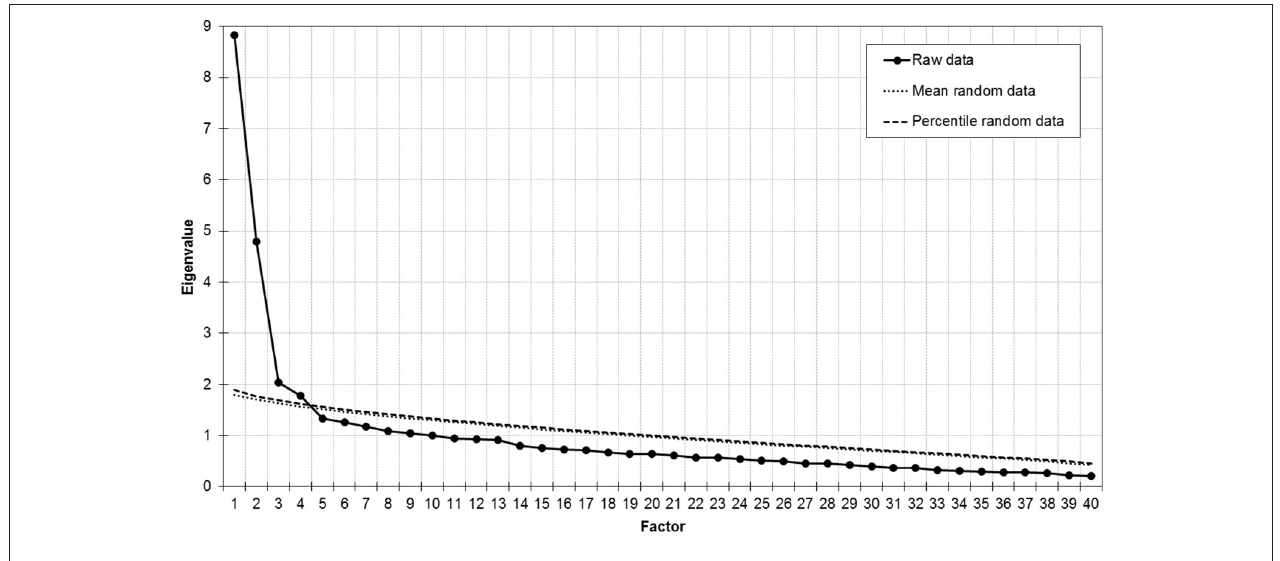
FIGURE 1 | Scree plot and parallel analysis of eigenvalues in study 1.